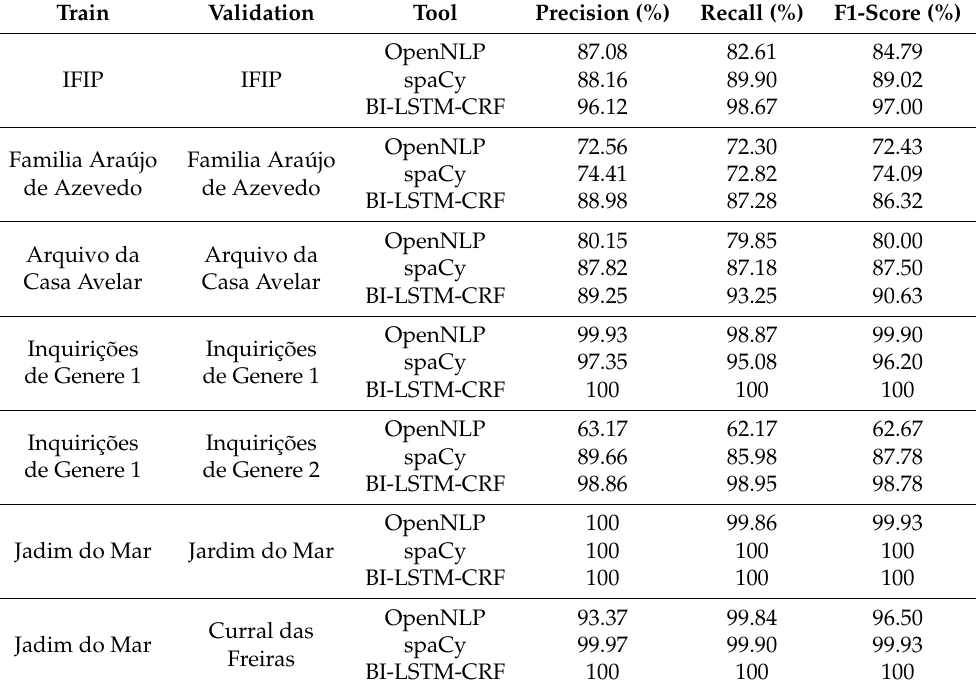
Table 2. Individual NER models